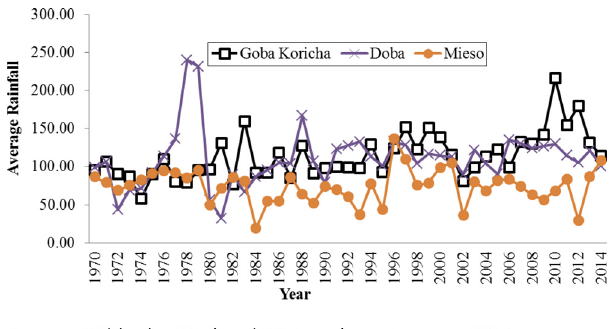
Figure 3. Average crop season rainfall in the three districts